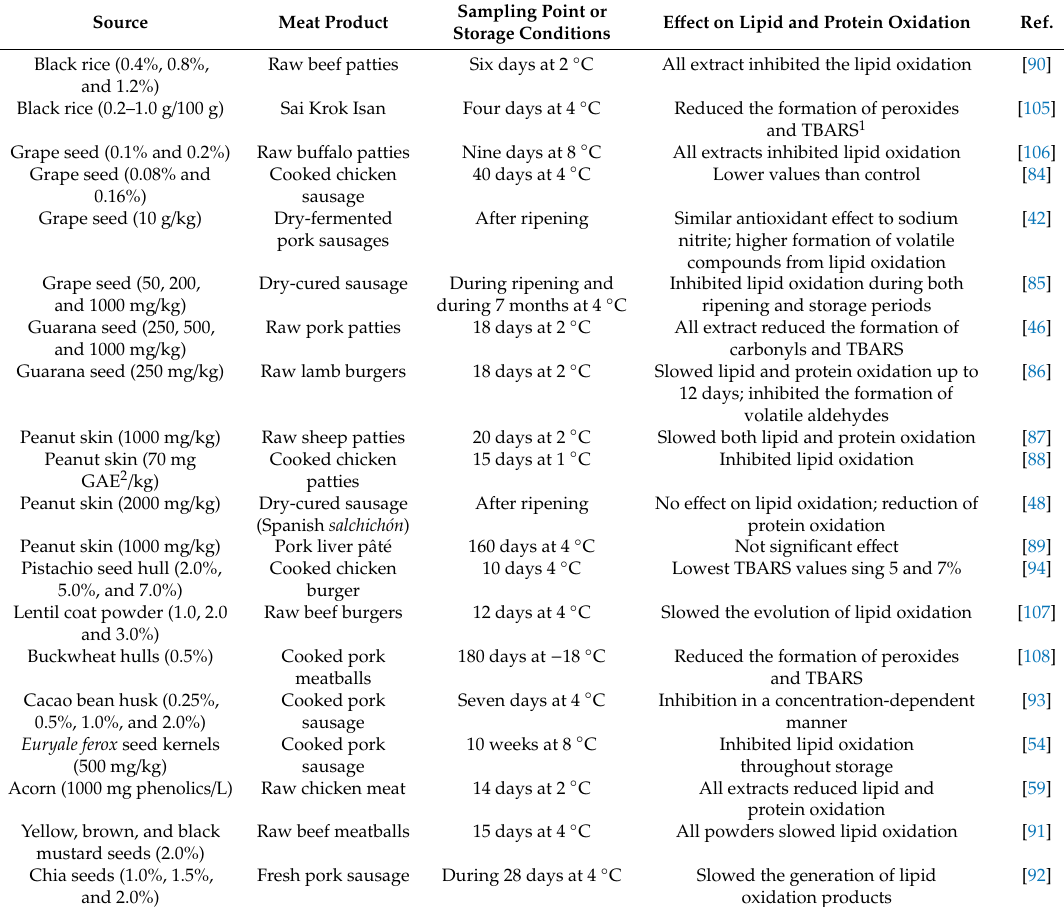
Table 4. Influence of seed extracts on the lipid and protein oxidation of meat